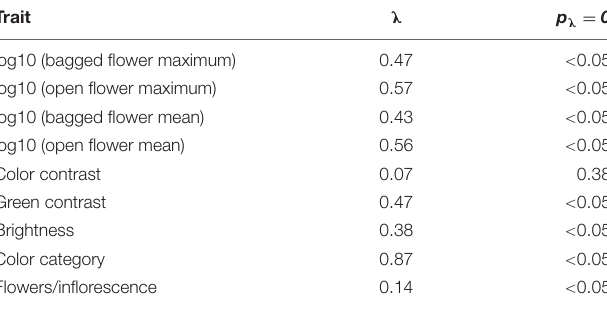
TABLE 1 | Phylogenetic signal for measured traits and rewards in bumble bee visited plant species from the Eastern Alps.